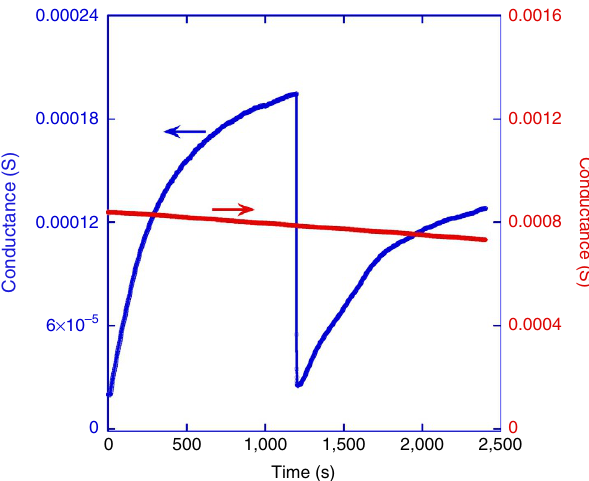
Figure 7 | Comparison of the behaviour of different substrates. Conductance versus time for In 2 O 3 /YSZ (blue,) and In 2 O 3 /MgAl 2 O 4 (red) samples, under constant current conditions. The field was applied at t ¼ 0, and the field direction was reversed for both samples at t ¼